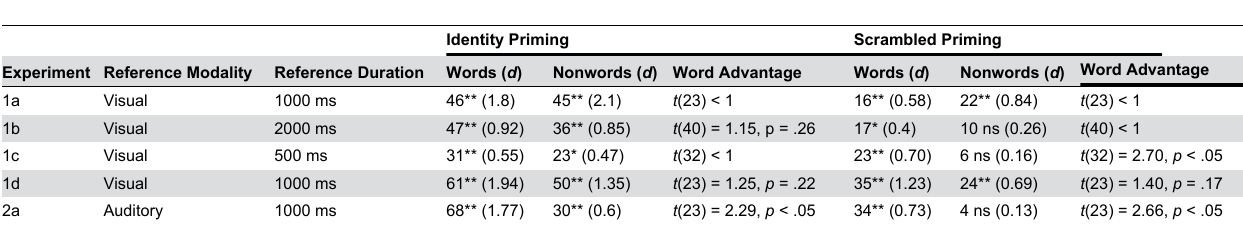
Table 5. Significance, magnitude, and effect sizes (Cohen’s d ) of identity and scrambled priming (in milliseconds) for Experiments 1a-d and 2a.